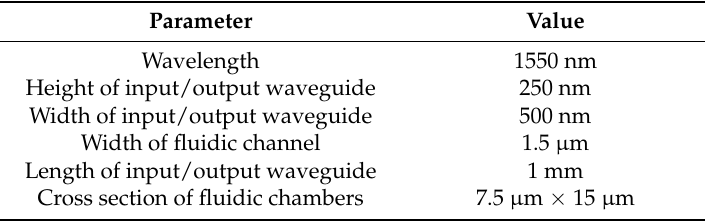
Table 4. Design parameters of opto-fluidic